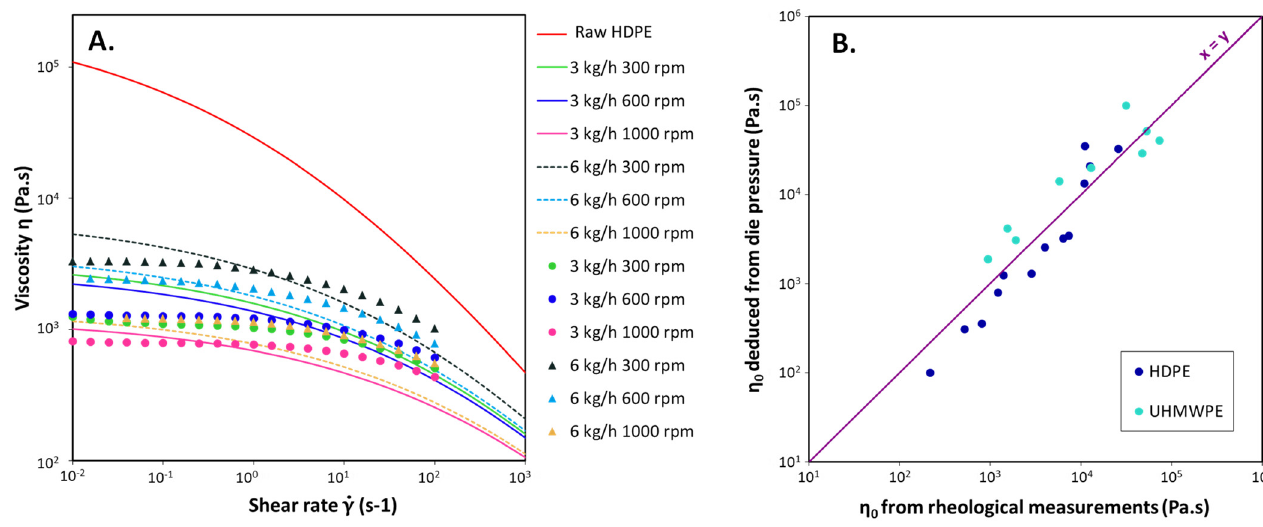
Figure 6. ( A ) Representation of calculated (lines) and measured (dots) viscosity curves for some HDPE extrusions at 390 °C for the indicated flow rates and screw rotation speeds; ( B ) Zero shear viscosities deduced from die pressure compared to the one obtained from rheological measurements.